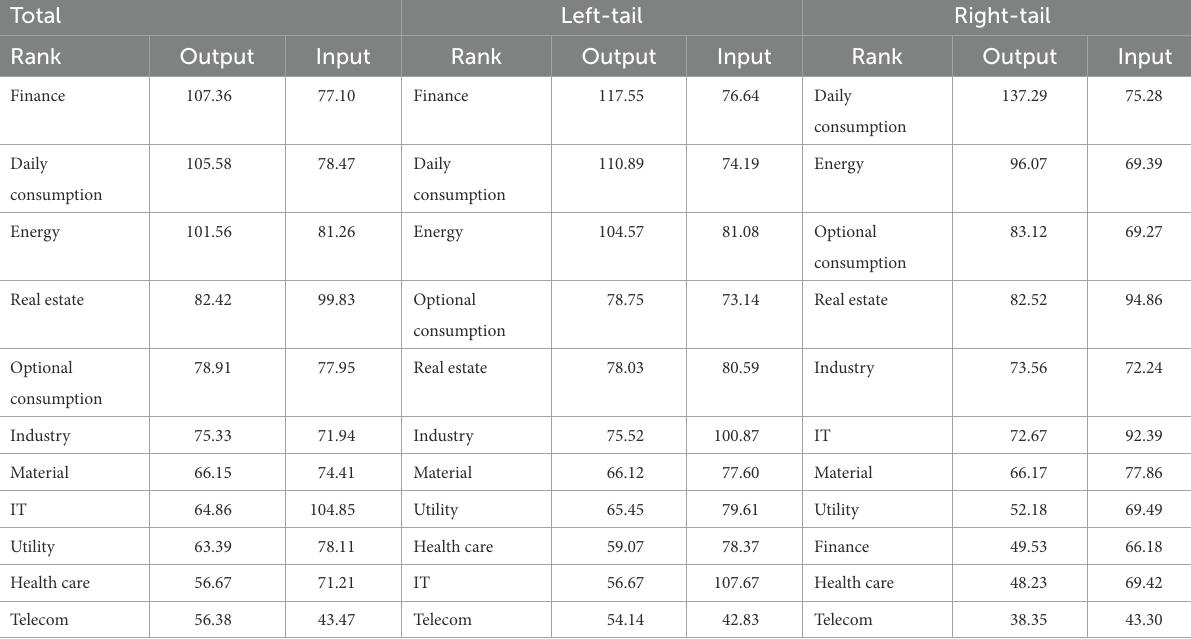
TABLE 4 Level of total cross-sector systemic risk spillover.